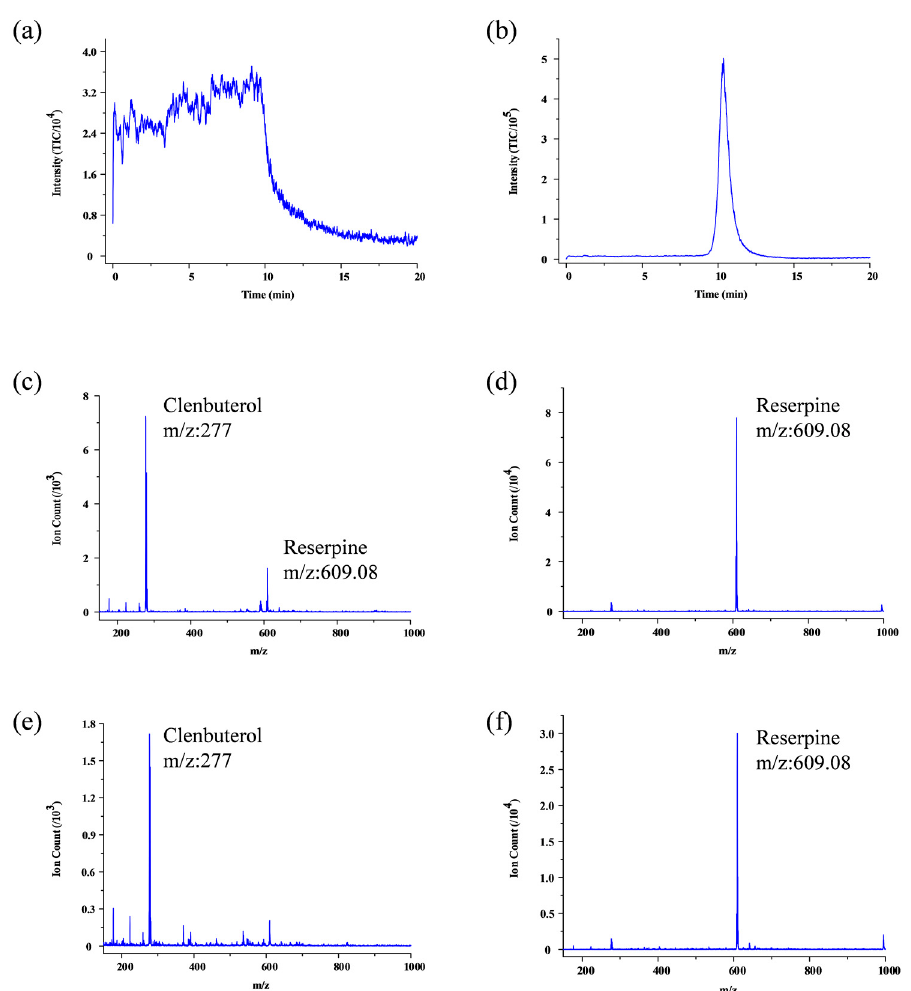
Figure 8. SPME experiment of reserpine and clenbuterol hydrochloride mixed solution: ( a ) clenbuterol hydrochloride (6.4 µM) change within 20 min on elution; TIC mass range from 276 to 277; ( b ) reserpine (0.205 µM) change within 20 min on elution; TIC mass range from 609 to 610; ( c ) clenbuterol hydrochloride ion counts of 0.205 µM Reserpine and 6.4 µM clenbuterol hydrochloride mixtures; ( d ) reserpine ion counts of the same mixtures as ( c , e ) clenbuterol hydrochloride ion counts of 0.205 µM reserpine and 3.2 µM clenbuterol hydrochloride mixtures; ( f ) reserpine ion counts of the same mixtures as ( e ).